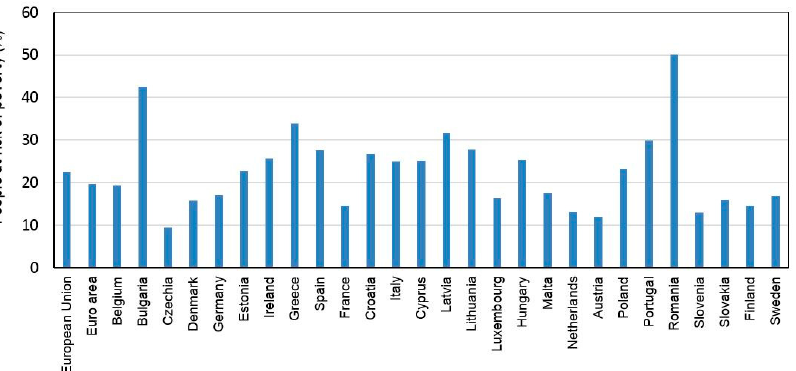
Figure 24. People at risk of poverty and social exclusions in rural areas of the EU in 2020, data from Eurostat [70].